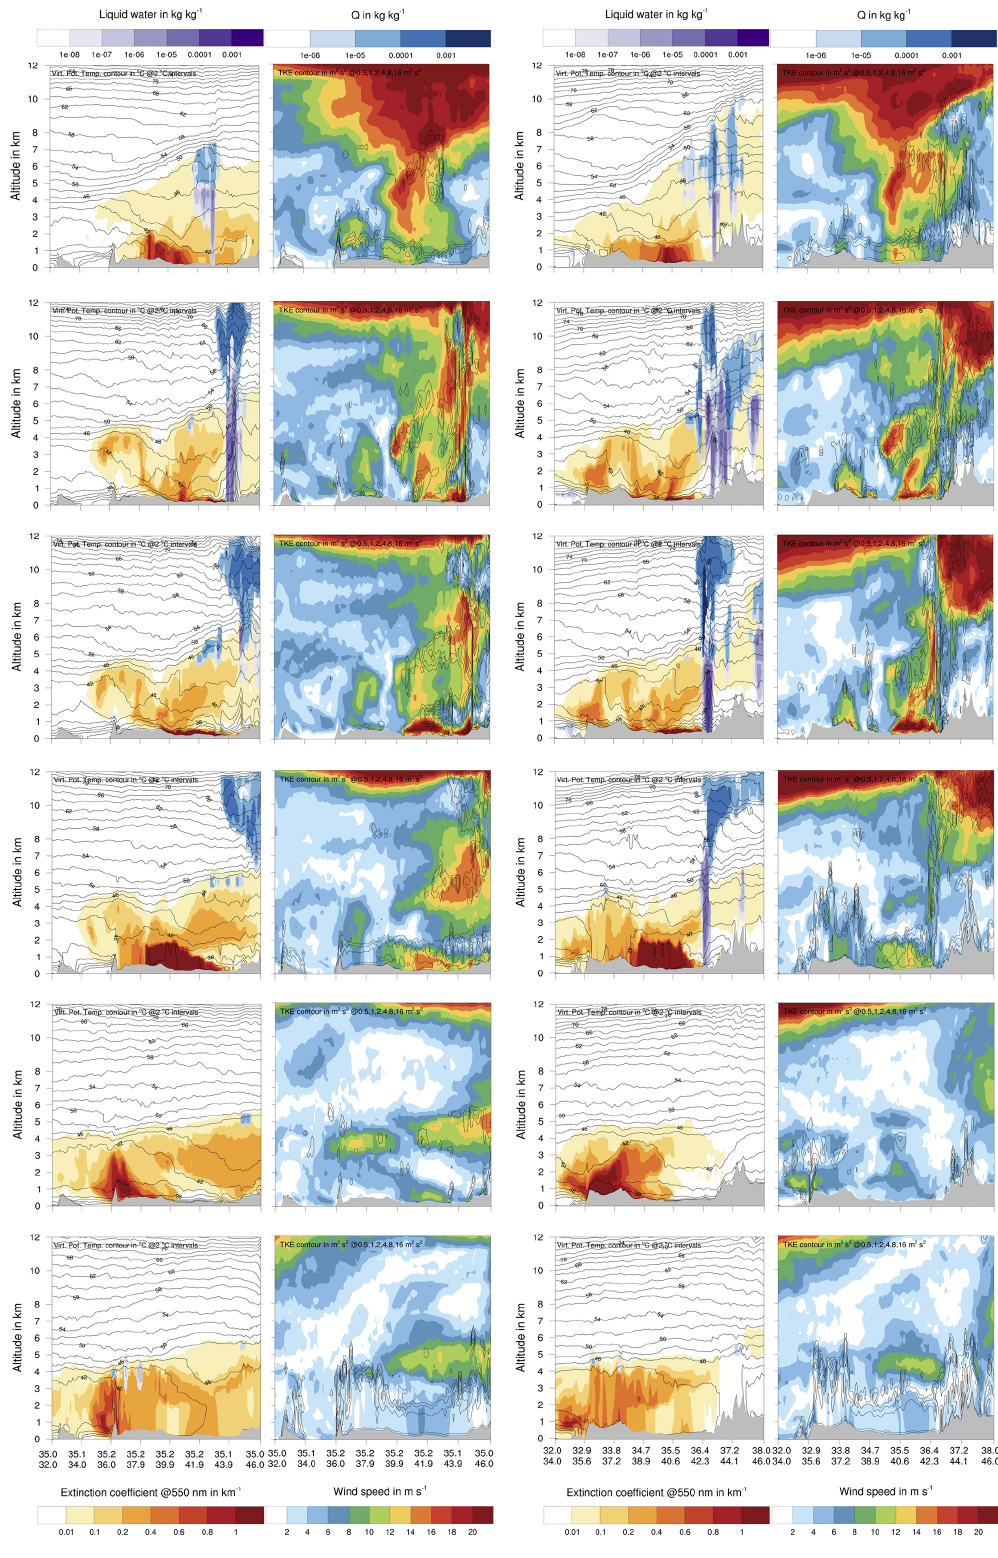
Figure A4. Vertical cross sections through ICON-ART model results along the transects in Fig. A6. The quantities displayed are the same as in Fig. 10; additionally shown are liquid water content and cloud ice, graupel and snow content Q. From top to bottom: